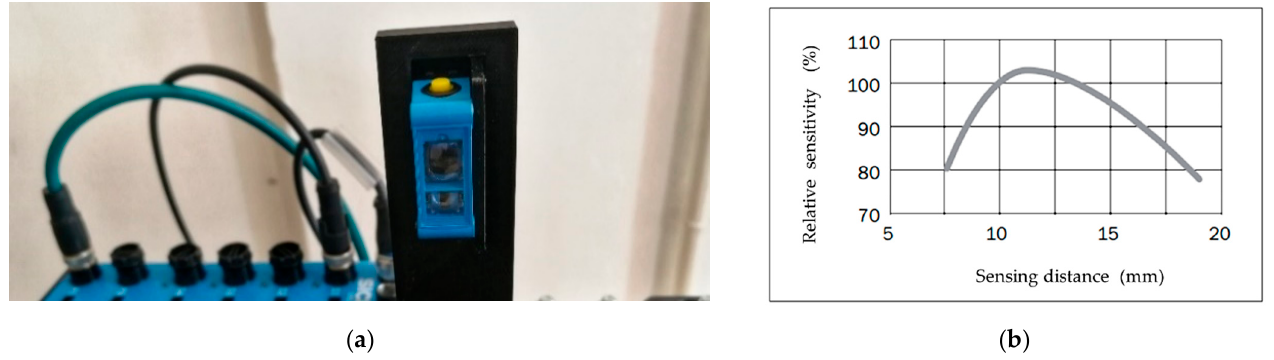
Figure 4. ( a ) Color sensor CSM—WP117A2P; ( b ) Sensing distance of sensor [20].